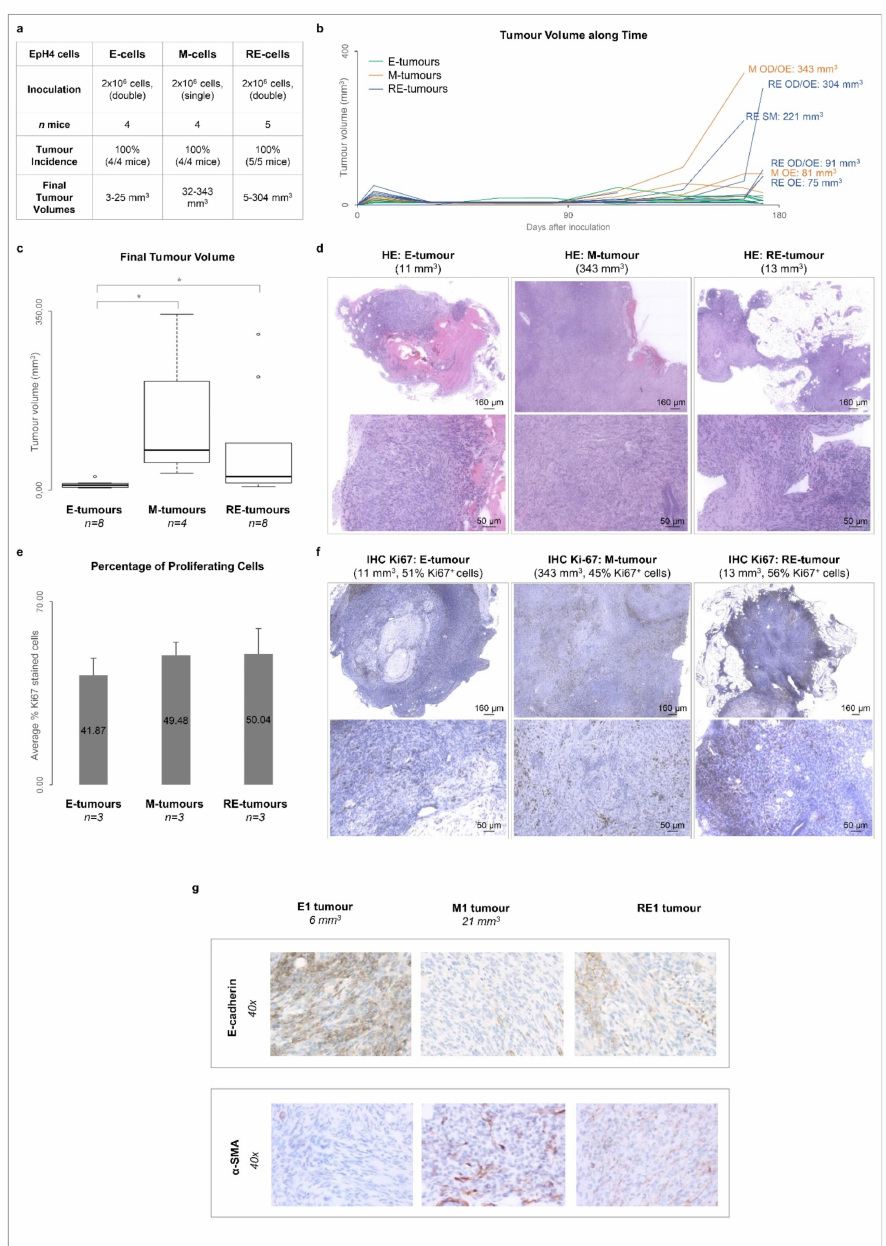
Figure 4. M and RE cells displayed higher in vivo tumourigenicity than E cells without retaining the original in vitro RNA profile. ( a ) Summary of the in vivo tumourigenicity assay performed with E, M and RE cells. ( b ) Growth curves representing the tumour volumes over time (E tumours in green, M tumours in orange and RE tumours in blue). ( c ) Final tumour volumes obtained for each cell type (* for p < 5.00 × 10 − 2 , with data analysis performed with the Mann–Whitney test). ( d ) Representative images of hematoxylin and eosin staining of E, M and RE tumours. Top and bottom images show different magnifications. ( e ) Average percentage of cells positive for Ki67 staining in 3 E, 3 M and 3 RE tumours. ( f ) Representative images of immunohistochemistry staining for Ki67. Top and bottom images show different magnifications. ( g ) E-cadherin and α -SMA immunohistochemistry staining of representative E, M and RE